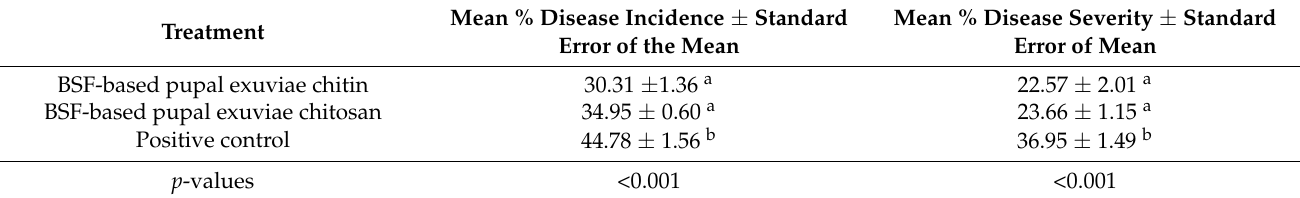
Table 3. Bacterial wilt disease incidence (DI) and disease severity